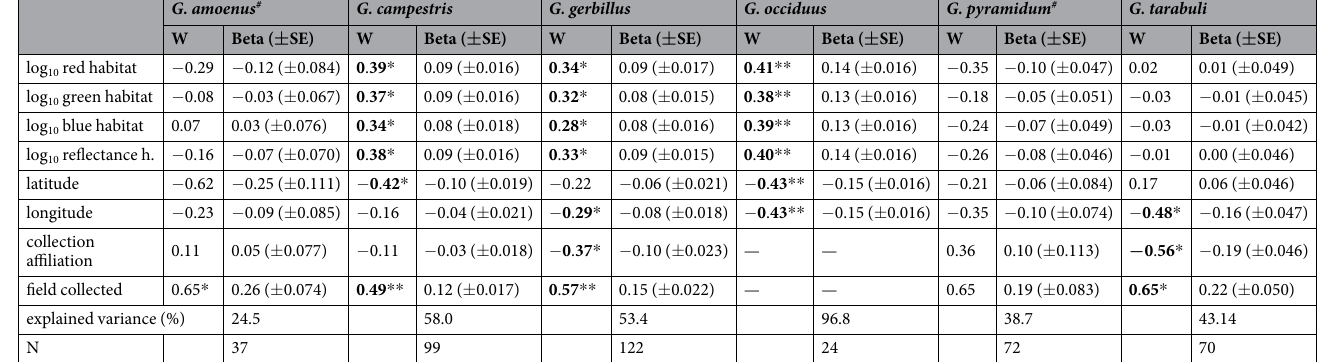
Table 2. Partial least squares regression (PLSR) analyses results for the dorsal fur colour (synthetic colouration include RGB colours and total reflectance) and habitat colouration, geographic coordinates, field and collection affiliations for Gerbillus . Results are presented separate analyses for species with N > 20. Significance levels of regression coefficients of predictors: ** < 0.01, * < 0.05. Explained variance (%) in the response variable by the PLSR model. W, weights of predictors’ contribution of variables to PLSR models, explaining more than 5% of the total variance are indicated in bold. # No important PLSR component was detected for G . amoenus and G . pyramidum models. − indicates that the variable was not included in the